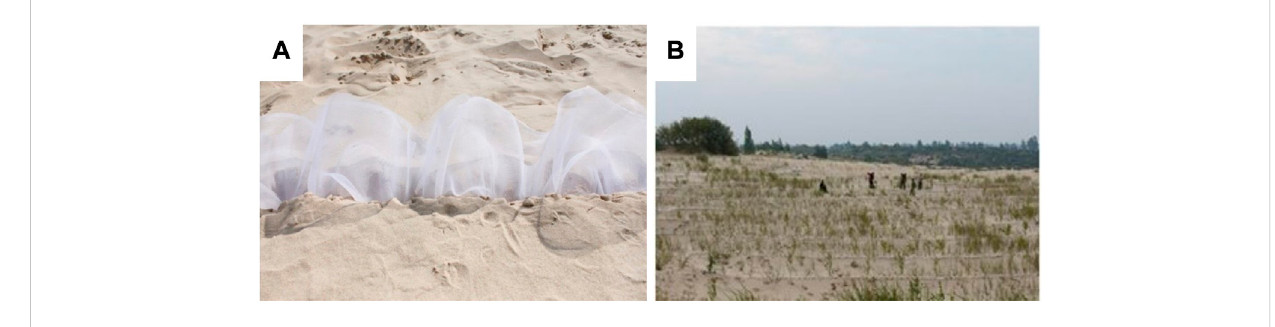
FIGURE 1 Gauze sand barrier (A) and recovery effect after laying (B)